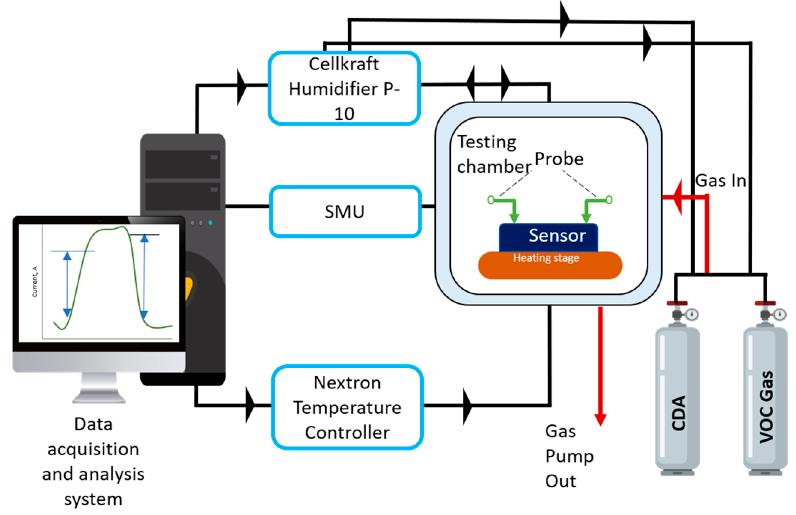
Figure 2. Schematic of illustration CH 3 COOH testing